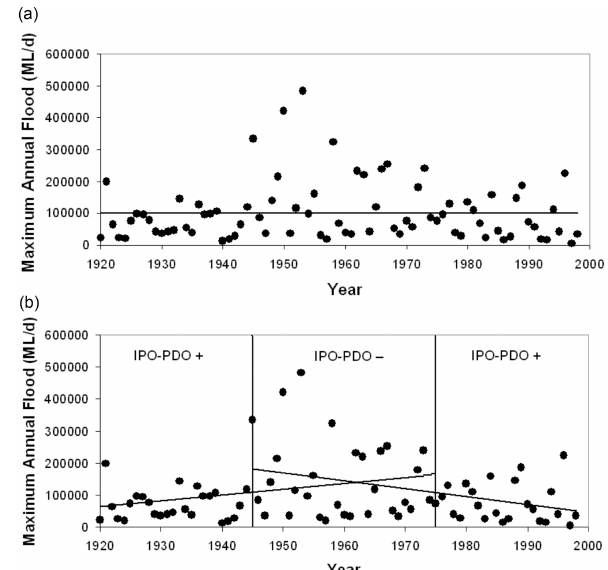
Figure 6. Trends in annual maximum flood timeseries for all years. (b) Trends in annual maximum flood timeseries for 1920–1975 and 1945–1998.